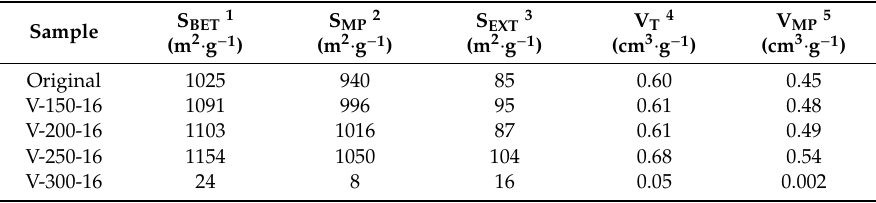
Figure 4. N 2 adsorption–desorption isotherms at −196 °C of the original NH 2 -MIL-125(Ti) and after treatment under vacuum at different temperatures for 16 h. Table 2. Porous texture characterization of the NH 2 -MIL-125(Ti) and after treatment under vacuum at different temperatures for 16 h.